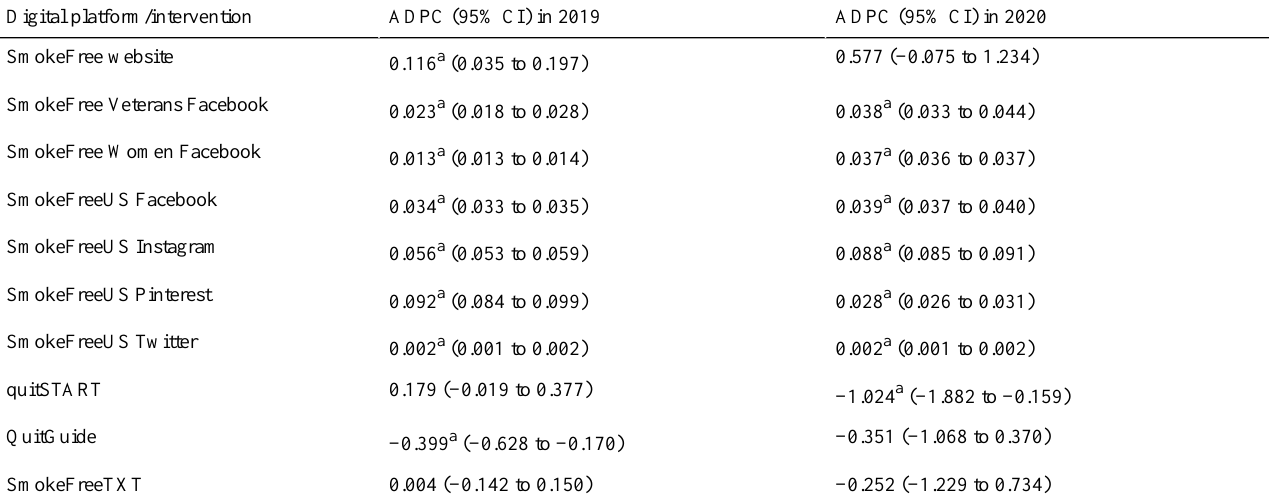
Table 2. Average daily percent changes (ADPCs) in the number of SmokeFree.gov initiative digital platform visitors, followers, and subscribers from January to April 2019 and